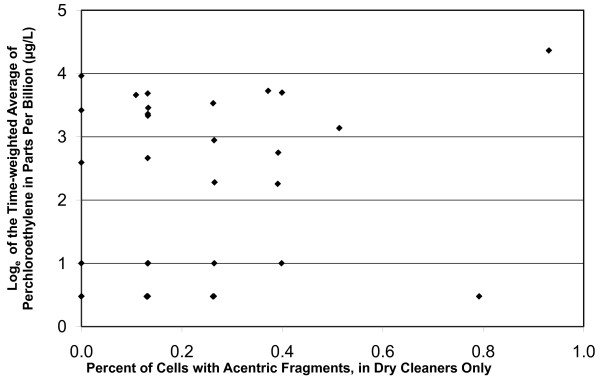
Frequencies of acentric fragments by time-weighted average of PCE in the dry cleaners. None of the laundry workers had acentric fragments. The frequencies of acentric fragments and blood PCE levels are correlated (R2 = 0.49; p = 0.0026).